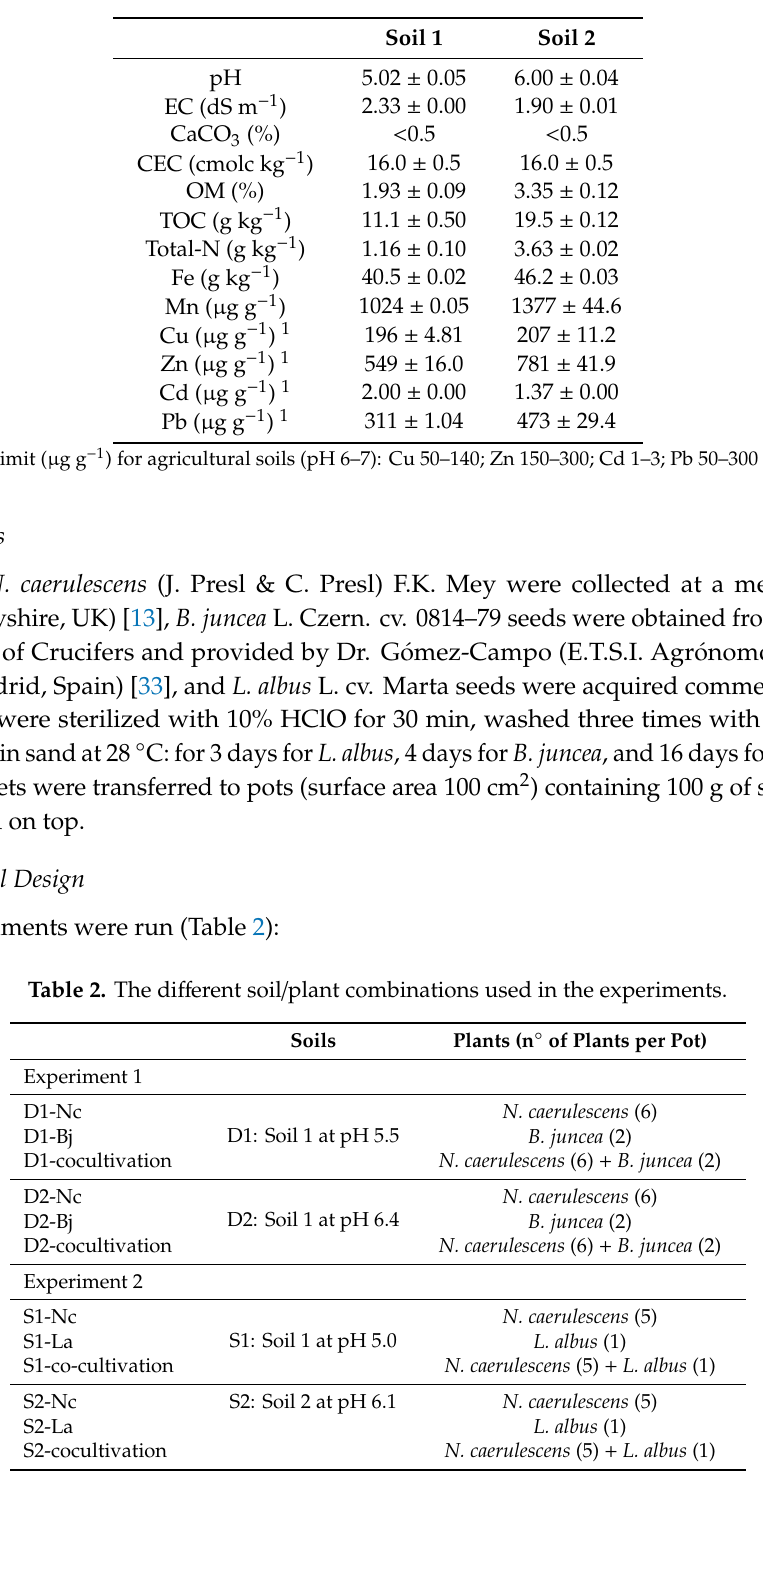
Table 1. Characteristics of the soils (mean ± standard error).